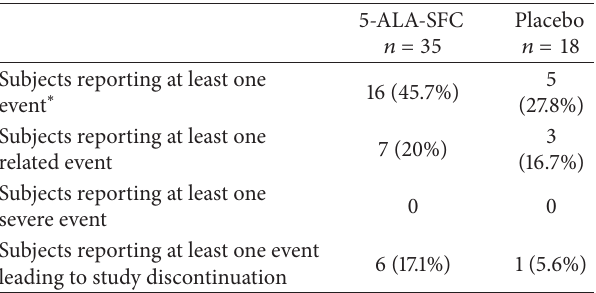
Table 2: Summary of adverse